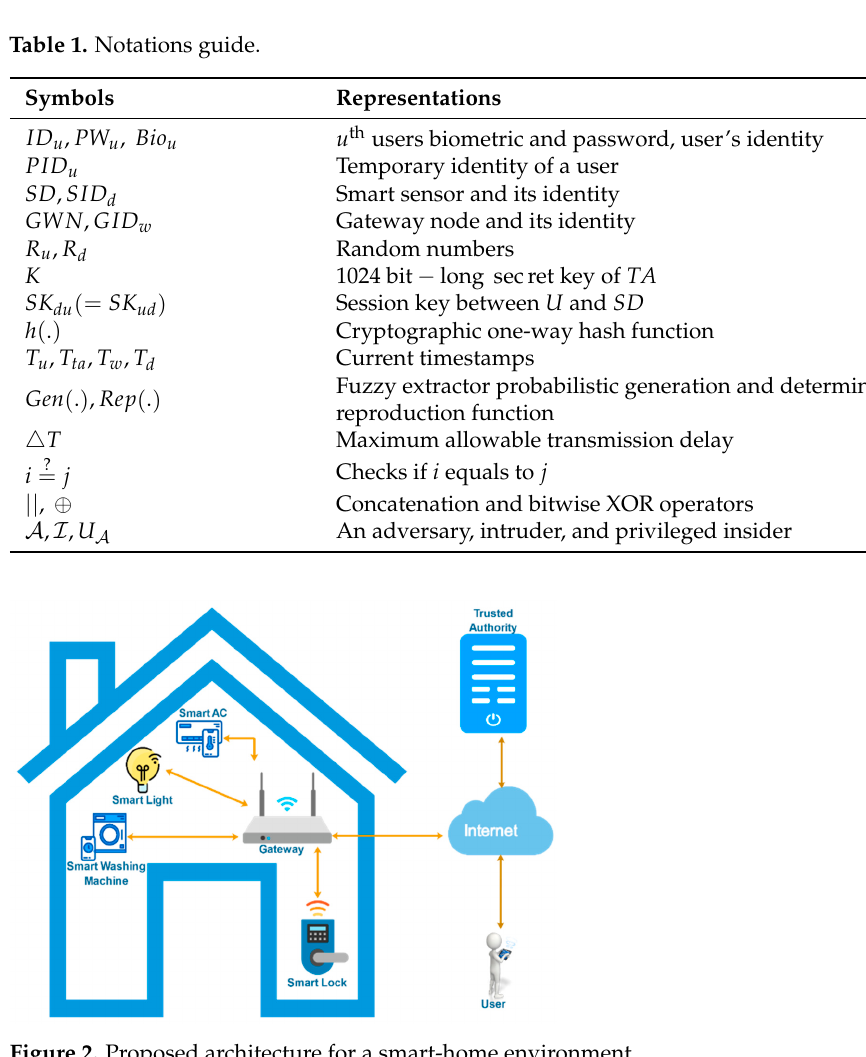
Figure 2. Proposed architecture for a smart-home environment. Table 1. Notations guide.